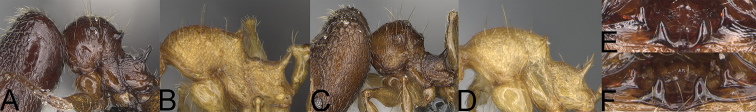
Pheidole
annemariae Forel, head and profile of major worker (A), hypostomal teeth (E), profile of minor worker (B). Pheidole
marieannae sp. nov., head of major worker (C), hypostomal teeth (F), profile of minor worker (D).